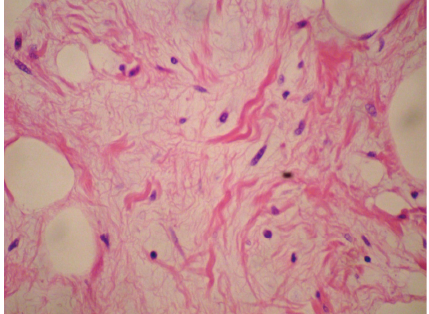
Figure 2: Spindle cell lipoma component shows mature fat cells withinterveningblandspindlecells,setwithinloose/myxoidstroma containing ropey collagen, H&E, 600x.